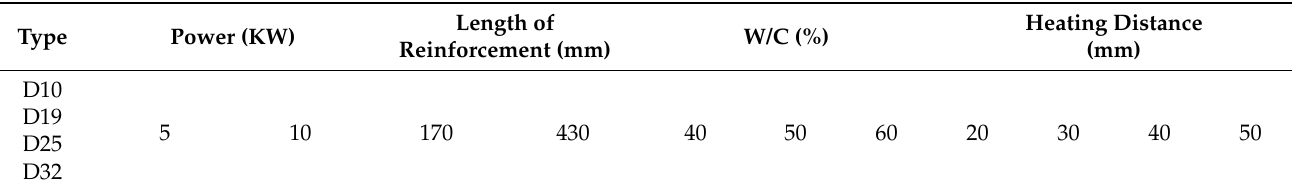
Table 1. Experimental factors and